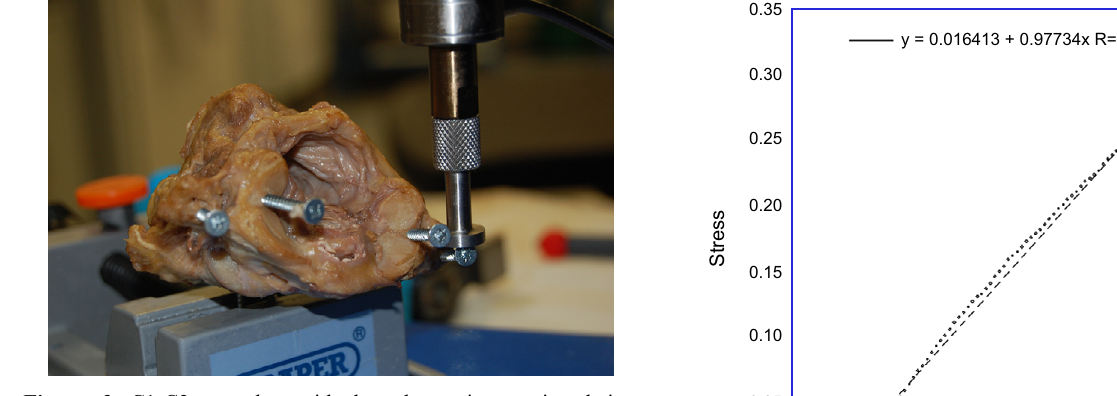
Figure 3. C1-C2 complex with lateral rotation testing being demonstrated.